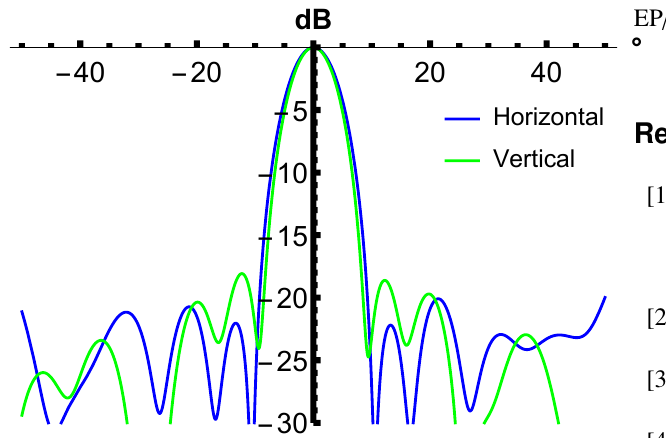
Figure 4. Response of the SAMI-U candidate array in figure 3 to a point source at ( θ,φ ) = (0 , 0) at frequency 16 GHz. The maximum sidelobe is below − 18 dB in both the horizontal (blue) and vertical (green) planes.